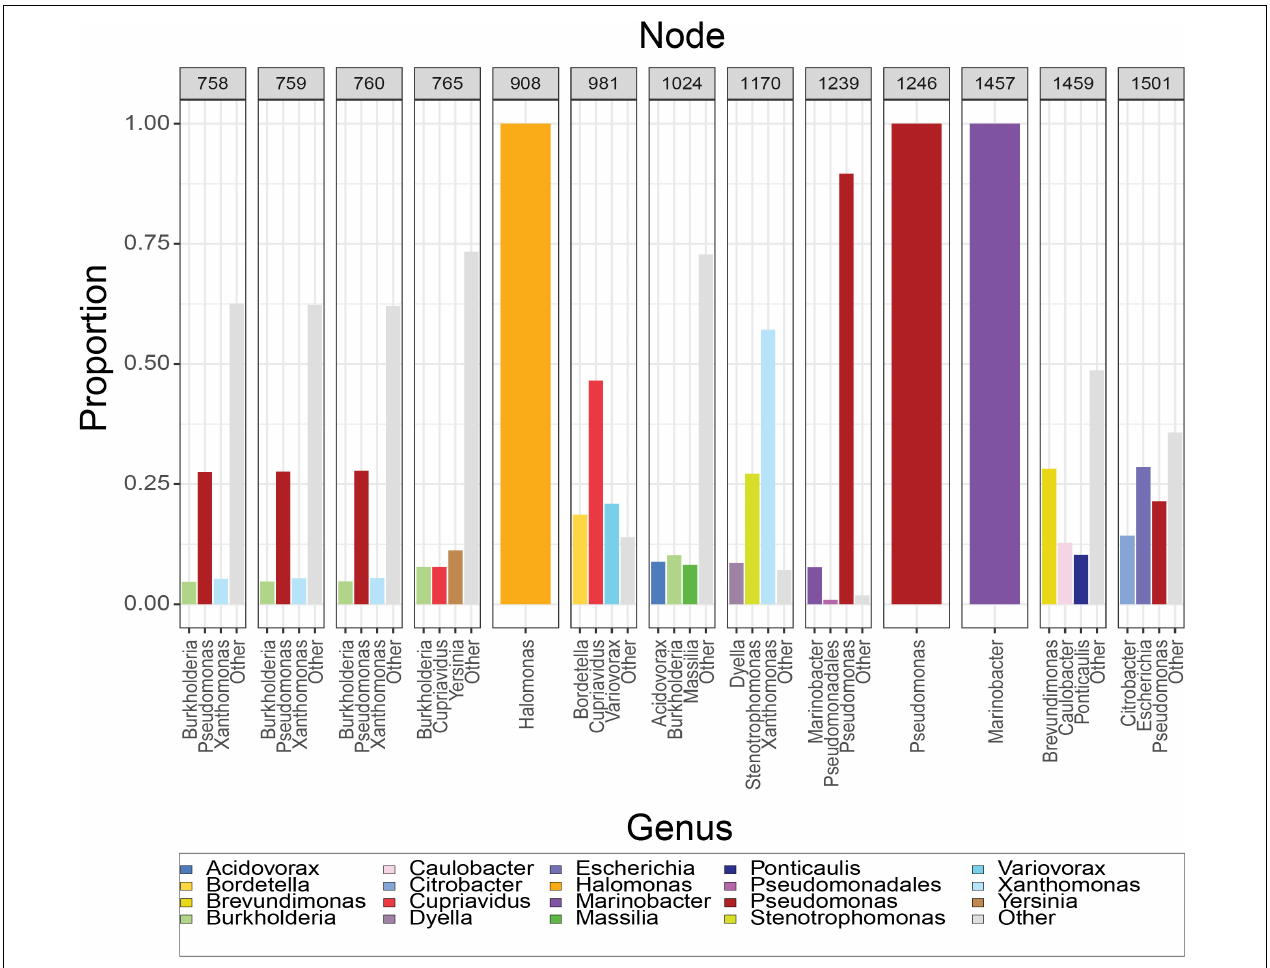
FIGURE 2 | Composition of resurrected MotB-ASRs. For each node, the set of tips descendant from that node was used to calculate the proportion of genera downstream from that node. Majority genera are indicated in legend and the top three contributors to each node noted on axis. Nodes 908, 1246, and 1457 have descendants that are solely Halomonas , Pseudomonas and Marinobacter , respectively, while others are mixtures.